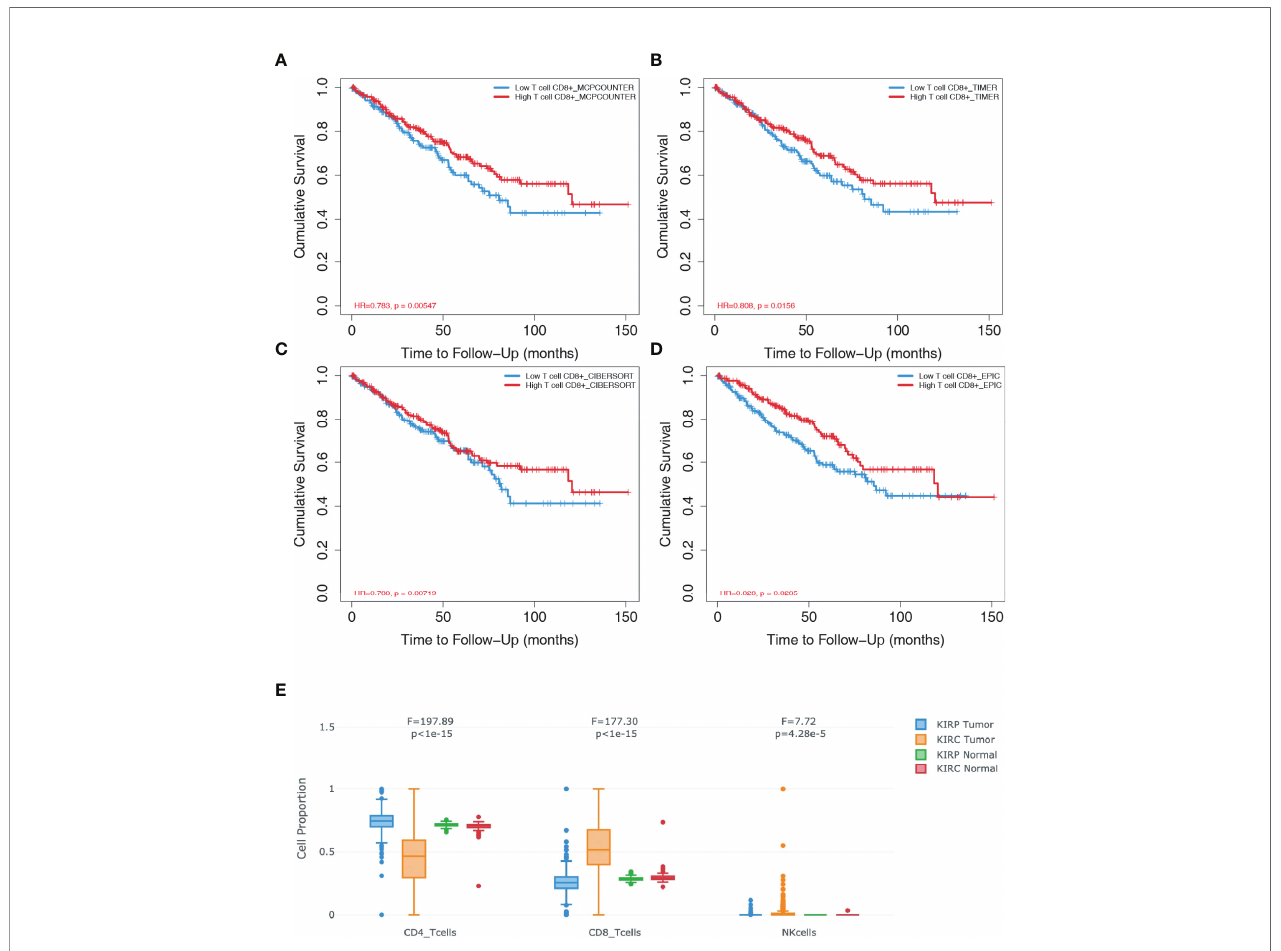
FIGURE 1 | CD8+ T cells exert prognostic value in clear cell renal cell carcinoma (ccRCC). The database TIMER2.0 (http://timer.comp-genomics.org/) was used to assess the relationship of in fi ltrated CD8+ T cells in ccRCC biopsies. (A) Survival analysis from the MCPCOUNTE database indicating the correlation between high in fi ltration of CD8+ T cells and improved prognosis in patients with ccRCC. (B) Survival analysis from the TIMER database showing the correlation between high in fi ltration of CD8+ T cells and improved prognosis in patients with ccRCC. (C) Survival analysis from the CIBERSORT database indicating the correlation between high in fi ltration of CD8+ T cells and improved prognosis in patients with ccRCC. (D) Survival analysis from the EPIC database showing the correlation between high in fi ltration of CD8+ T cells and improved prognosis in patients with ccRCC. (E) Box plots showing the proportion of CD4+ T, CD8+T, and natural killer (NK) cells in ccRCC and papillary renal cell carcinoma (papRCC) biopsies,